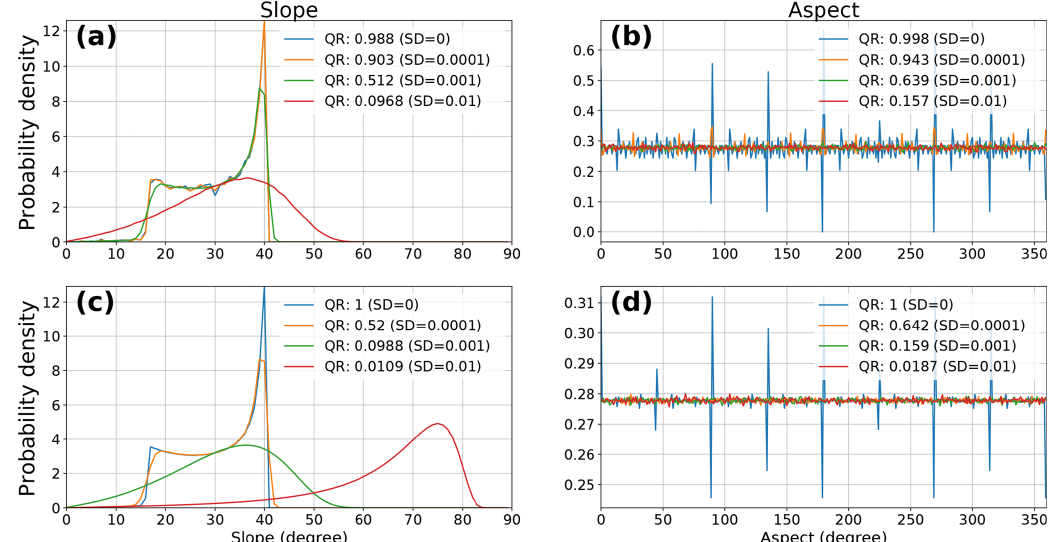
Figure 8. Slope (a, c) and aspect (b, d) probability distributions (1 ◦ bins) for a Gaussian hill with homogeneous noise at variable levels (SD = 0, 1 e − 2 , 1 e − 3 , 1 e − 4 ) for n = 101 (a, b) and n = 1001 (c, d) . The introduction of small levels of noise washes the spikes out of the aspect distribution. Slope distributions are steeper with the introduction of higher noise levels. Similar density functions are generated at similar QRs, despite differences in absolute noise